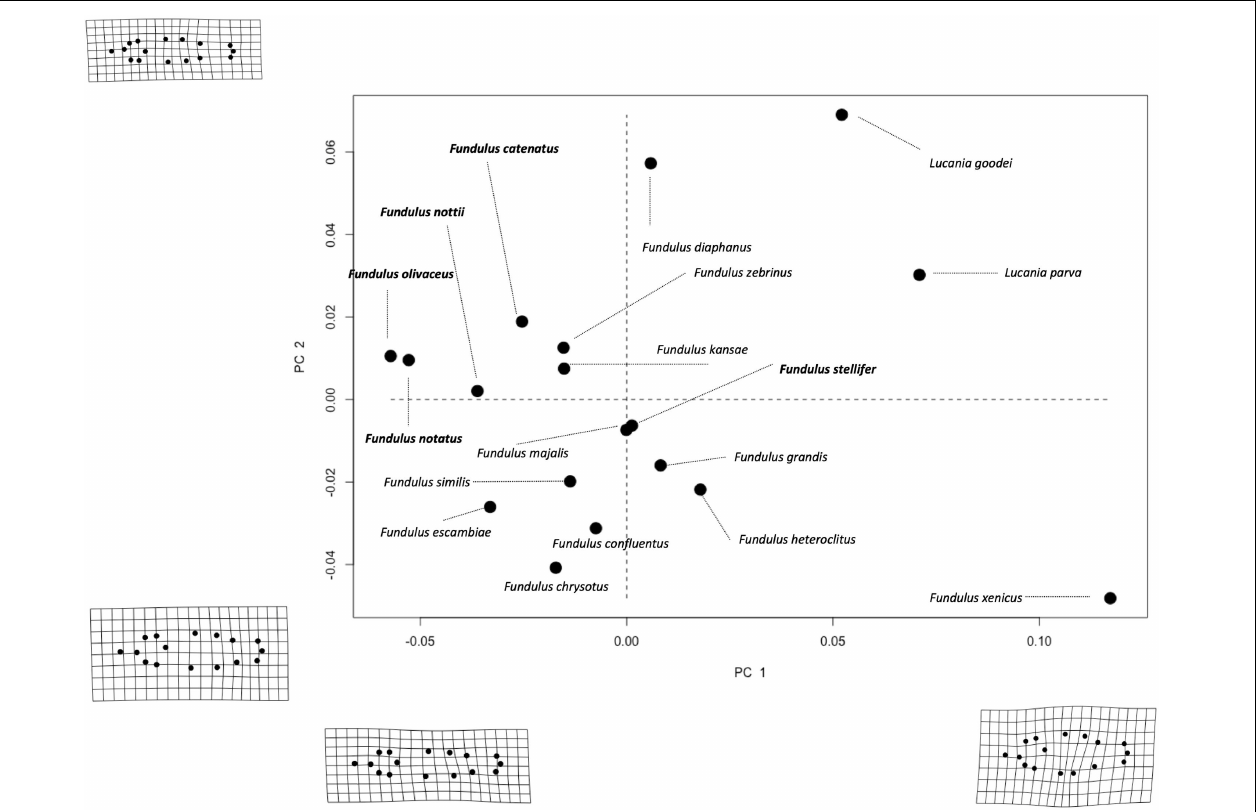
FIGURE 2 | Bivariate PC plot of species averages separated according to salinity niche (bold = freshwater/brackish and plain text = saltwater species). Deformation grids (magnified 3 × ) associated with maximum and minimum values of each PC are shown on the corresponding axes. PC1 and 2 explain 52.3 and 23.2% of the variation in body shape among species,